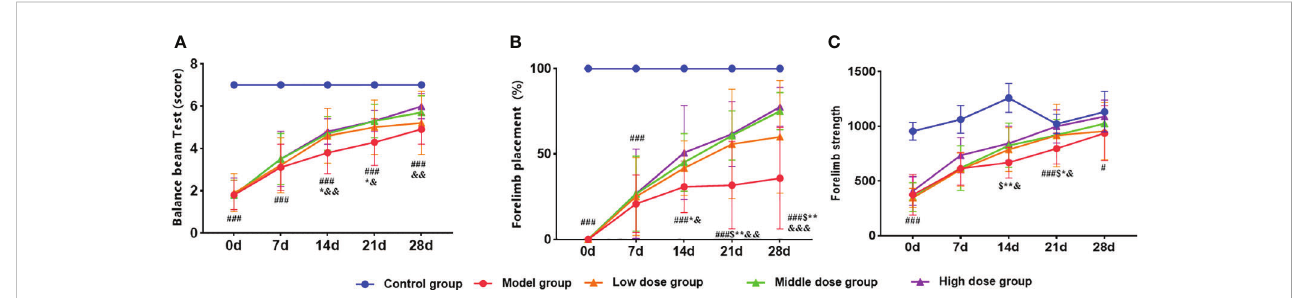
FIGURE 9 Effect of different doses of hUCMSCs on the recovery of neurological/motor function in MCAO rats. (A – C) Balance beam test, forelimb placement test, and forelimb muscle strength test results. Data are presented as mean ± SD. # P<0.05, ### P<0.001 vs control group; $ P<0.05 low dose group vs model group; *P < 0.05, **P < 0.01 middle dose group vs model group; & P < 0.05 high dose group vs. model group.